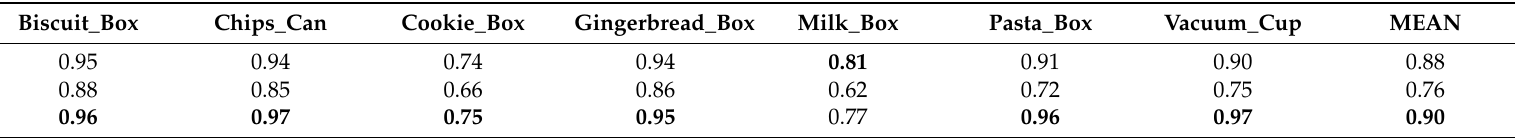
Table 5. Quantitative evaluation of the 6D pose in terms of average closest point distance (ADD-S).